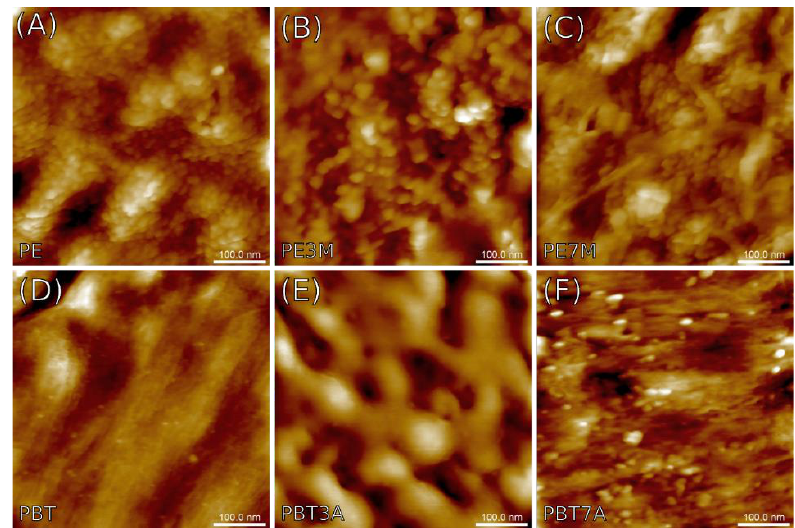
Figure 9. The AFM topographical images of the composites under study taken from the fracture cross-sections. Samples: ( A ) PE; ( B ) PE3M; ( C ) PE7M; ( D ) PBT; ( E ) PBT3A; ( F ) PBT7A. Table 3. Topographical and nanomechanical parameters of the surfaces of metallographic microsec- tions: S q —RMS surface roughness, Y mean —mean Young’s pseudo-modulus, F adh —average adhesion